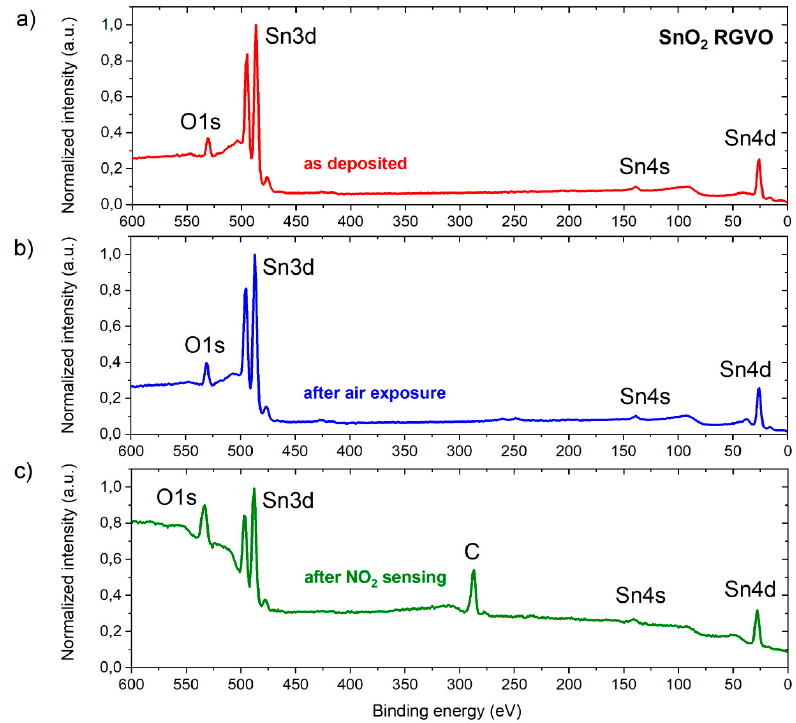
Figure 4. X-ray photoelectron spectroscopy (XPS) survey spectra with main core level lines of RGVO SnO x nanolayers ( a ) as deposited; ( b ) after air exposure; ( c ) after NO 2 sensing experiments.